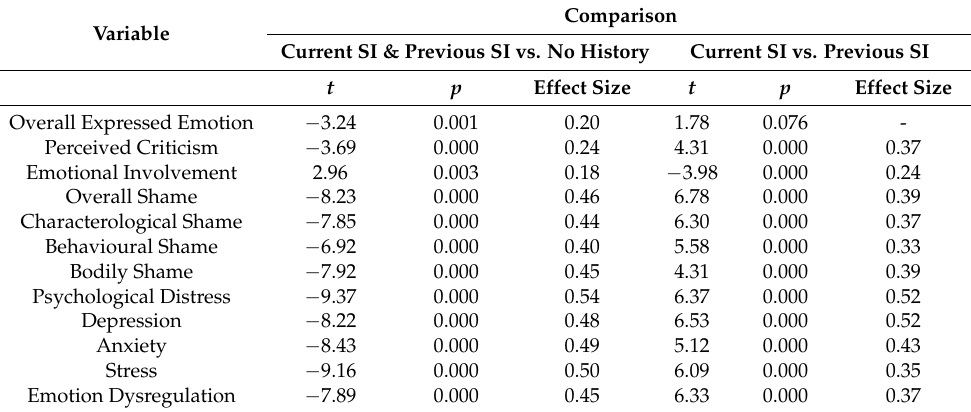
Table 2. Follow up linear contrasts for significant